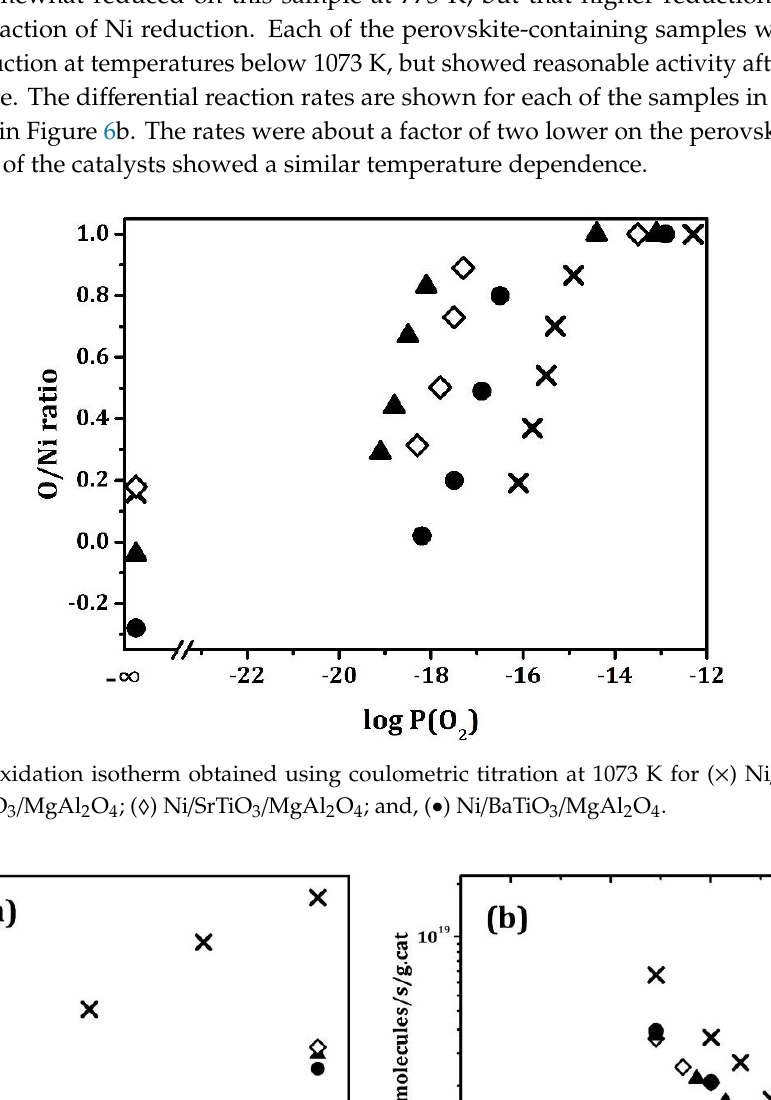
Figure 6. ( a ) Methane conversion for methane dry reforming (MDR) reaction at 873 K as a function of reduction temperature for ( × ) Ni / MgAl 2 O 4 ; ( (cid:78) ) Ni / CaTiO 3 / MgAl 2 O 4 ; ( ♦ ) Ni / SrTiO 3 / MgAl 2 O 4 ; and, ( • ) Ni / BaTiO 3 / MgAl 2 O 4 . Total flow rate was controlled at 120 mL min − 1 with CH 4 and CO 2 flow being 5 mL min − 1 and 10 mL min − 1 , respectively. ( b ) Arrhenius plots for methane dry reforming (MDR) reaction for ( × ) Ni / MgAl 2 O 4 ; ( (cid:78) ) Ni / CaTiO 3 / MgAl 2 O 4 ; ( ♦ ) Ni / SrTiO 3 / MgAl 2 O 4 ; and, ( • ) Ni / BaTiO 3 / MgAl 2 O 4 after each catalyst was reduced at 1073 K. The total flow rate was controlled at 120 mL / min with CH 4 and CO 2 flow being 5 mL min − 1 and 10 mL min − 1 ,